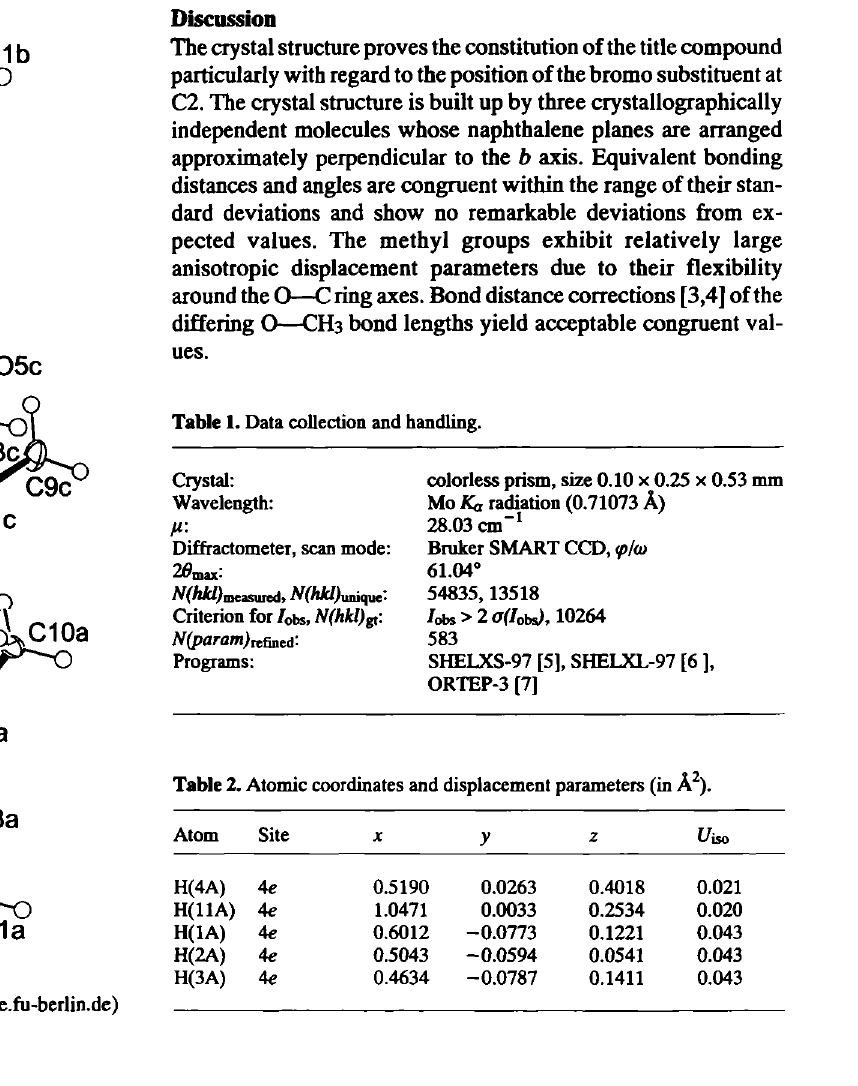
Table 2. Atomic coordinates and displacement parameters (in A 2